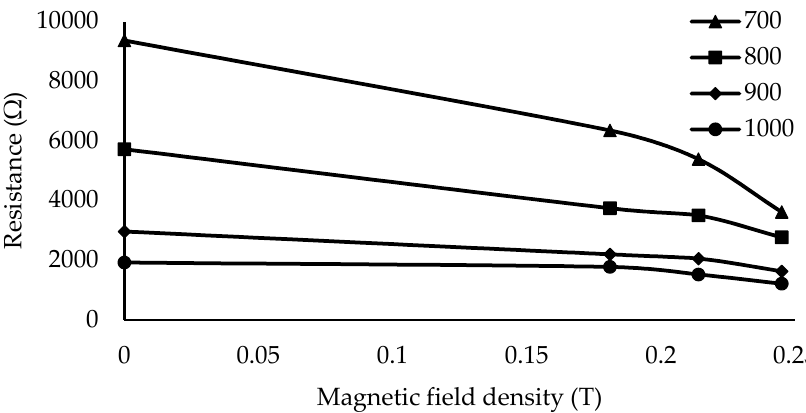
Figure 13. Resistance reduction in different magnetic fields at applied forces of 700, 800, 900, and 1000 g .